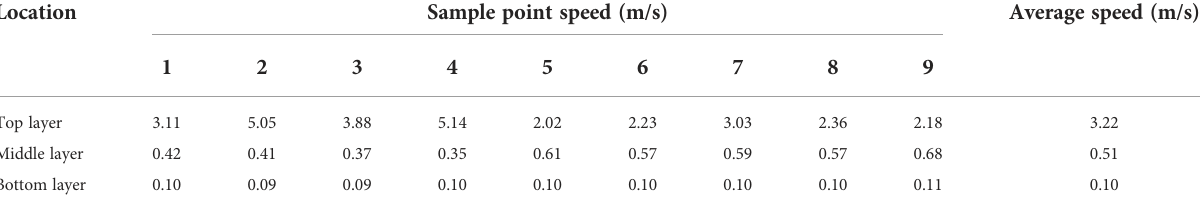
TABLE 4 Velocity distribution of each layer within the canopy. Location